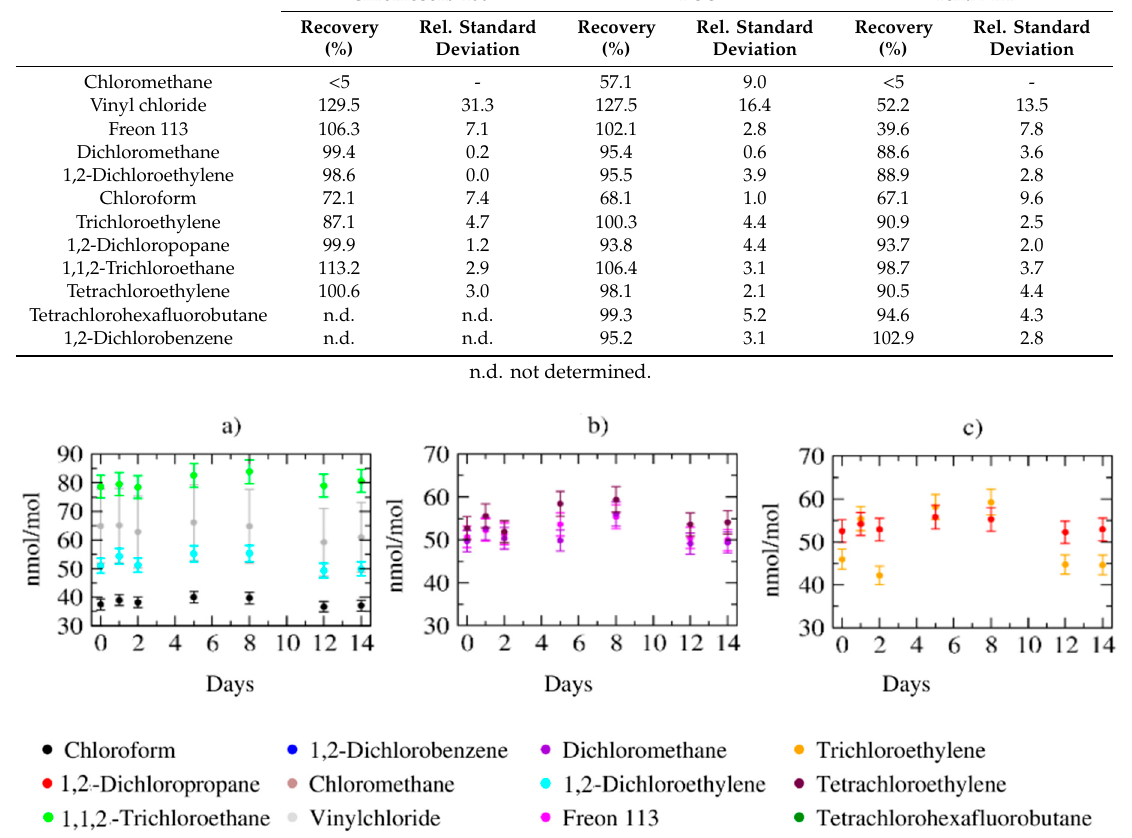
Figure 4. Storage stability of halogenated hydrocarbons on Chromosorb 106. ( a ) for 1,1,2-trichloroethane, chloroform, 1,2-dichloroethylene, vinylchloride; ( b ) for Freon 113, tetrachloroethylene, chloromethanedichloromethane. ( c ) for 1,2-dichloropropane, trichloroethylene.